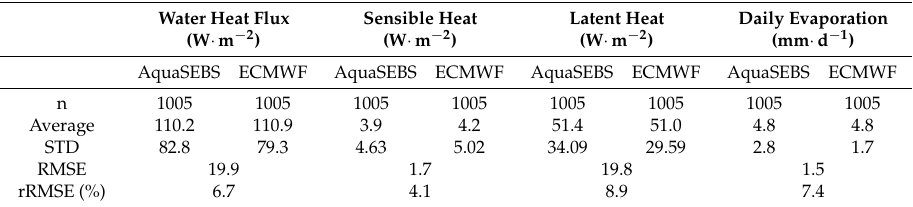
Table 6. Comparison of the heat fluxes values calculated by the AquaSEBS and ECMWF models over Lake Victoria (January 2010 to September